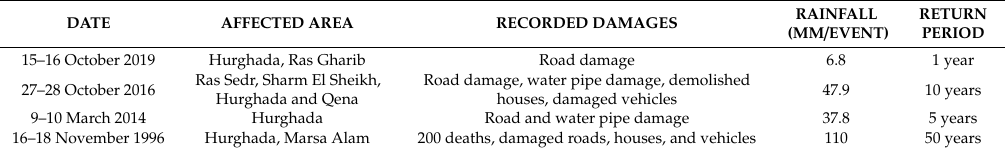
Figure 1. The study area of ( a ) the Hurghada catchment area, ( b ) Hurghada with georeferenced photo locations, and ( c ) the georeferenced photos showing the destructive e ff ects of flood events [81,82]. Table 1. Historical records of devasting urban flash floods in Hurghada, Egypt